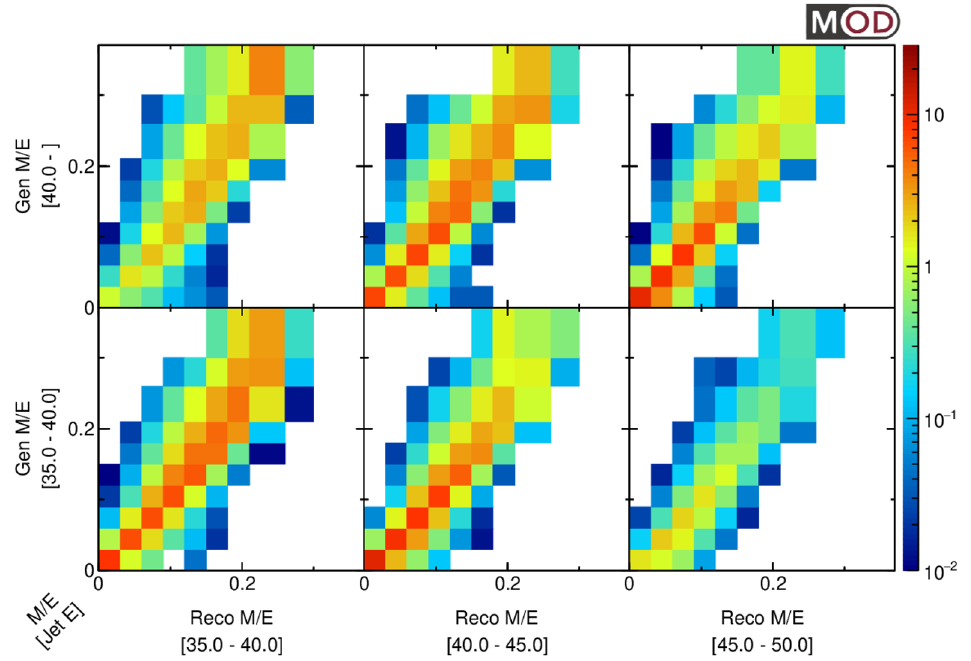
Figure 5 . Partial response matrix for M/E , in bins of E . Each block is the sub-matrix for the indicated E range. The matrix is row-normalized across all E ranges: the color scale indicates the probability density of a given generator level (“Gen”) jet being smeared into a different reconstructed level (“Reco”)